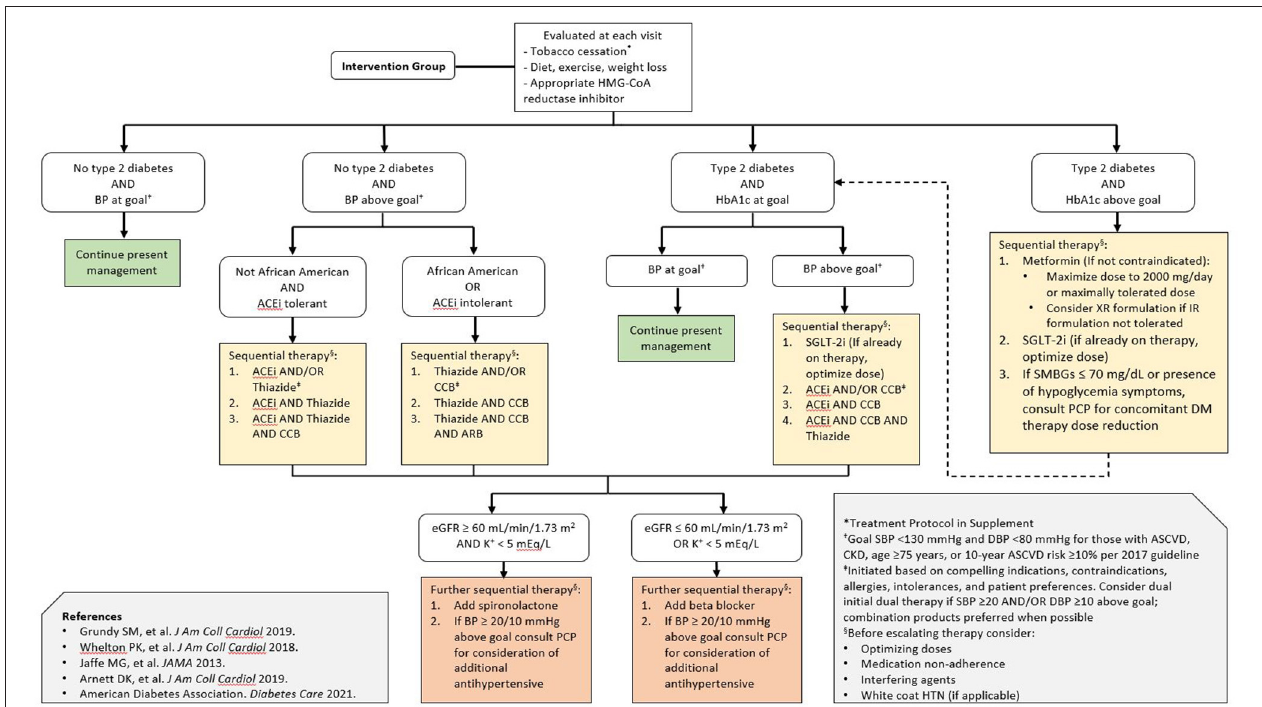
FIGURE 2 | Pharmacist-directed intervention treatment algorithm. The treatment algorithm was derived from professional society guidelines for the primary prevention of cardiovascular disease as well as blood pressure, glucose, and lipid lowering. Special consideration is given to the early initiation of SGLT-2 inhibitors in patients with diabetes, given the evidence supporting their efficacy in heart failure prevention and current guideline recommendations. BP represents blood pressure; ACEi angiotensin converting enzyme inhibitor; ARB angiotensin receptor blocker; CCB calcium channel blocker; SMBG self-monitored blood glucose; eGFR estimated glomerular filtration rate; PCP primary care physician; DM diabetes mellitus; SBP systolic blood pressure; DBP diastolic blood pressure; HTN